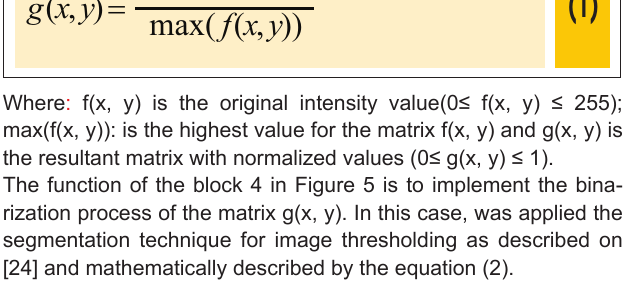
Figure 5 – Block Diagram of the image digital process of the proposed